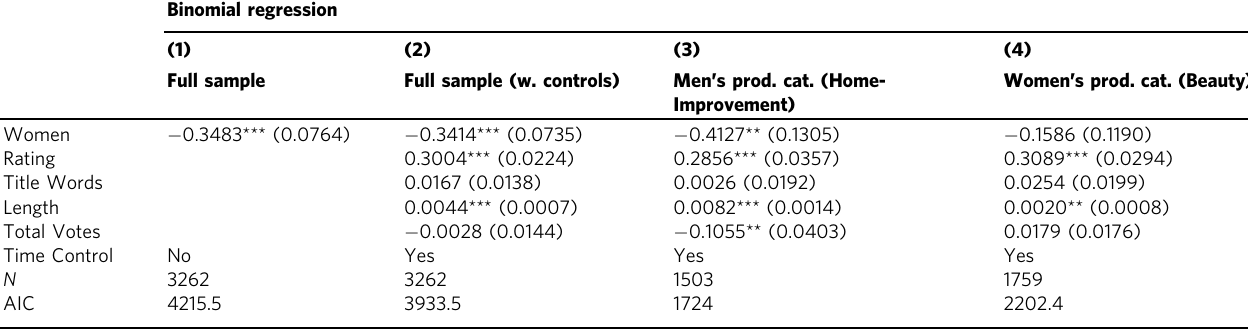
Table 7 Results of the relationship between gender and review